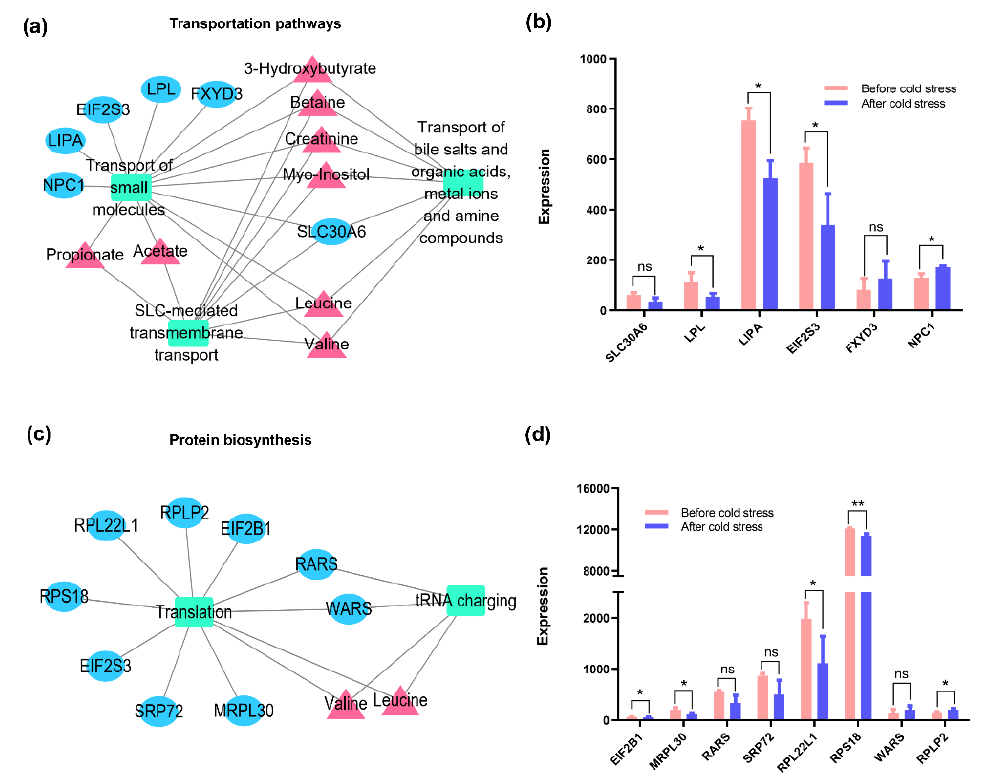
Figure 8. Networks between metabolites and genes involved in transportation pathways and protein biosynthesis. ( a ) Transportation pathways. ( b ) Protein biosynthesis. Triangles represent metab- olites, ovals represent genes, and rectangles represent the metabolic pathways. ( c ) The changes of gene expressions involved in transportation pathways. ( d ) The changes of gene expressions in- volved in protein biosynthesis. *: p -Value < 0.05; **: p -Value < 0.01; ns: no significance; SLC30A6 : solute carrier family 30 (zinc transporter), member 6; LPL : lipoprotein lipase; LIPA : lipase A, lyso- somal acid, cholesterol esterase; EIF2S3 : eukaryotic translation initiation factor 2, subunit 3 gamma; FXYD3 : FXYD domain containing ion transport regulator 3; NPC1 : Niemann-Pick disease, type C1; EIF2B1 : eukaryotic translation initiation factor 2B, subunit 1 alpha; MRPL30 : mitochondrial riboso- mal protein L30; RARS : arginyl-tRNA synthetase; SRP72 : signal recognition particle 72 kDa; RPL22L1 : ribosomal protein L22-like 1; RPS18 : ribosomal protein S18; WARS : tryptophanyl-tRNA synthetase; RPLP2 : ribosomal protein, large, P2.